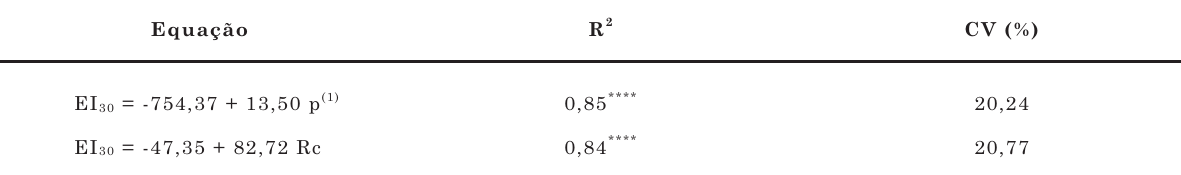
vs. precipitação e o índice EI 30